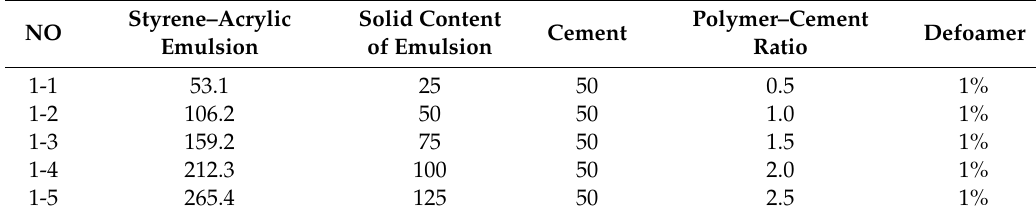
Table 5. Mix proportion of polymer curing